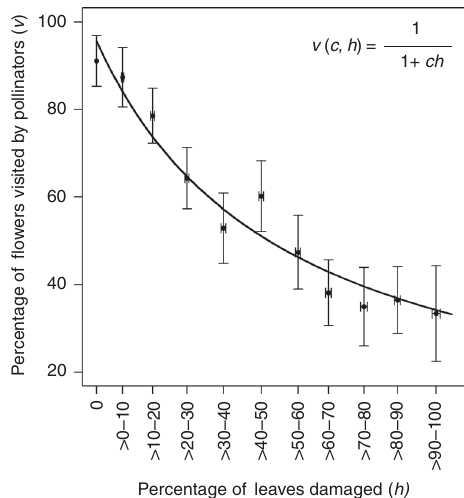
Fig. 2 Best fi t Type II functional form. Best fi t Type II functional response of pollinator visitation ( v ( c , h )) as a function of proportionate leaf damage ( h ). Error bars show standard error of the